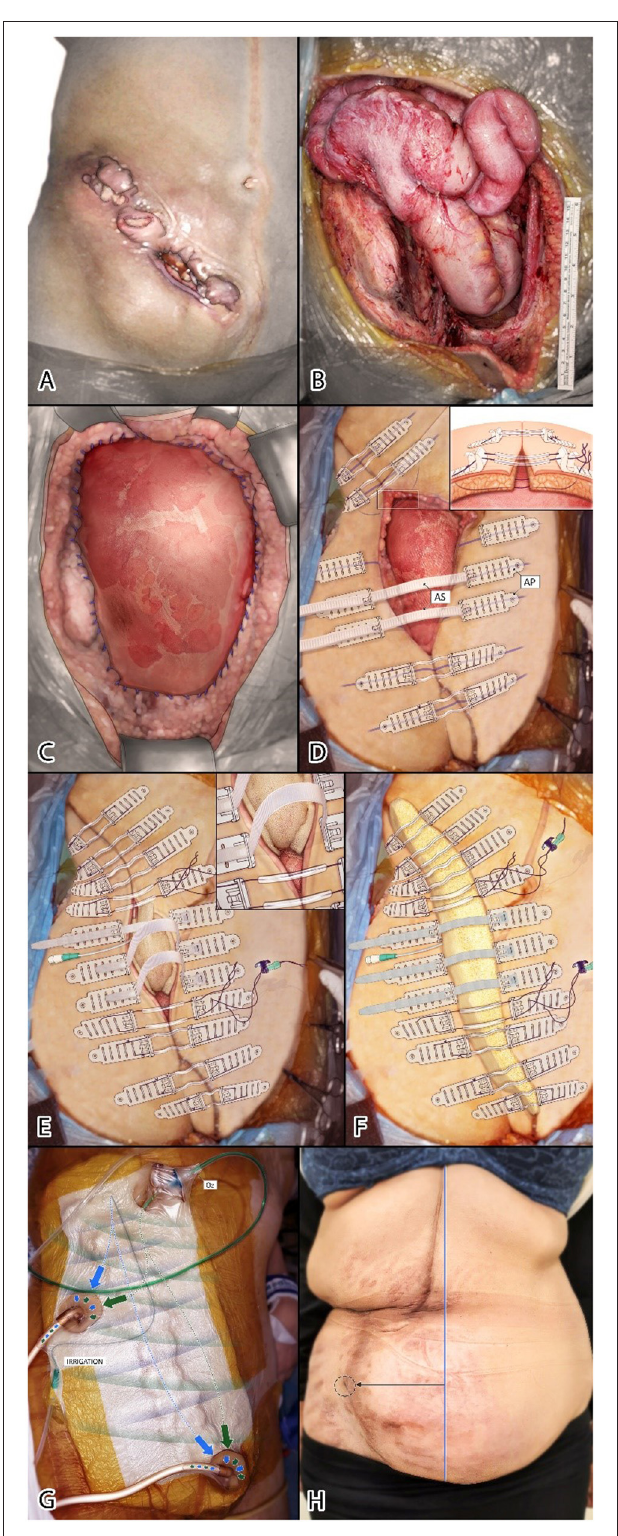
FIGURE 1 | (A) Recurrent ulcerated colonic adenocarcinoma involving abdominal wall. (B) Residual 26.5 × 18.5cm abdominal wall defect. (C) Vicryl